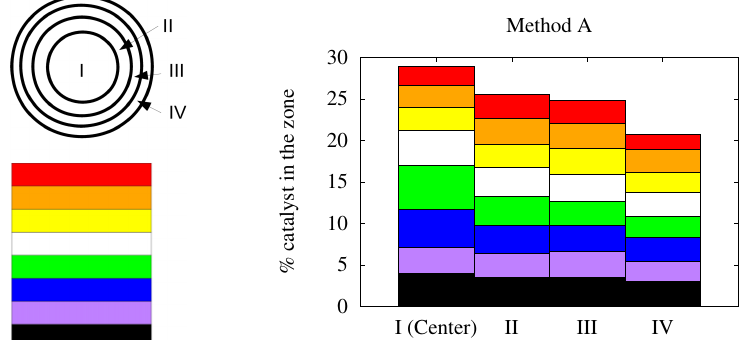
Figure 8. Zones of thickness measurement and distribution of the Al cylinder for the air blowing method.